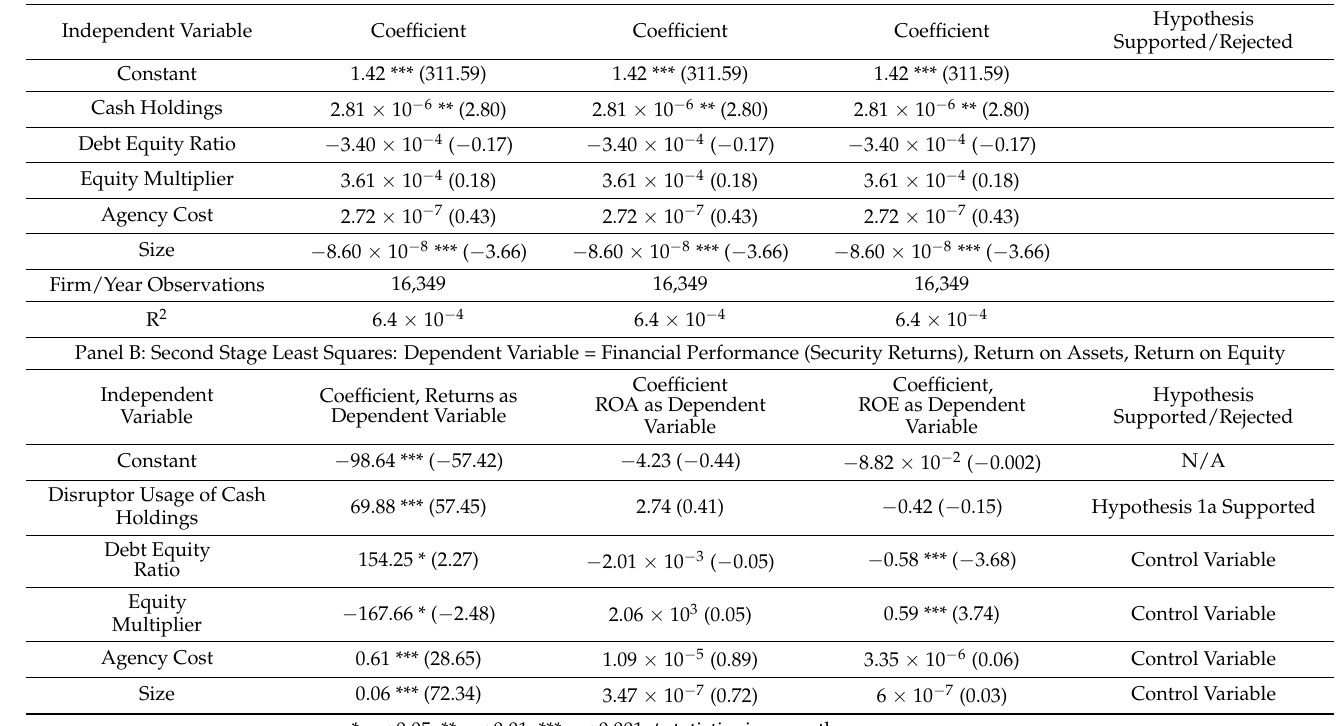
Table 2. Two-Stage Least Squares Regressions of Cash Holdings on Disruption, Followed by Disrup- tion on Financial Performance (Full Sample).